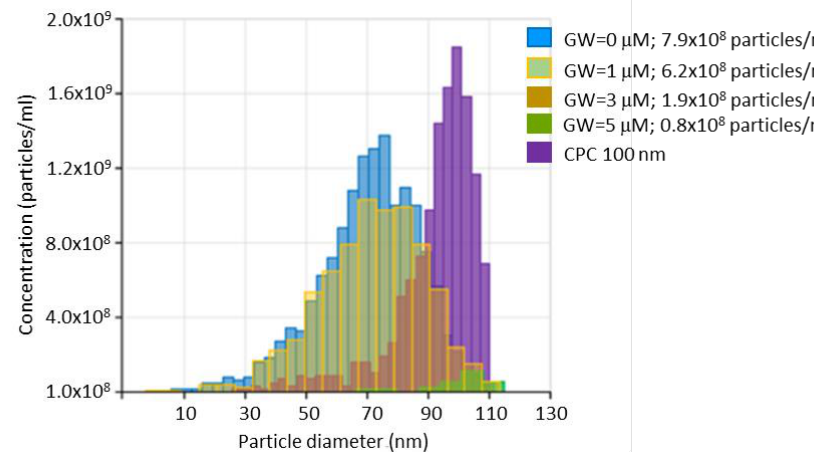
Figure 6. Exosomes size and concentration analysis following GW4869 treatments. T98G cells (10 6 cells into 60 mm plates) were incubated for 24 h with different GW4869 (GW) concentrations (0 – 1 – 3 – 5 μ M) in high-glucose media (supplemented with exosomes-free FBS). Exosomes were isolated with a Total Exosomes Isolation kit (Thermofisher) and analyzed in size and concentration by means of a qNANO Gold instrument (Izon, NP80 Nanopore; stretch = 49 nm; voltage = 0.1 V; pressure = 20 mbar). Calibration particles (CPC100, Izon, in purple) were used as size control. Particles concentrations/mL and diameters (nm) are reported.